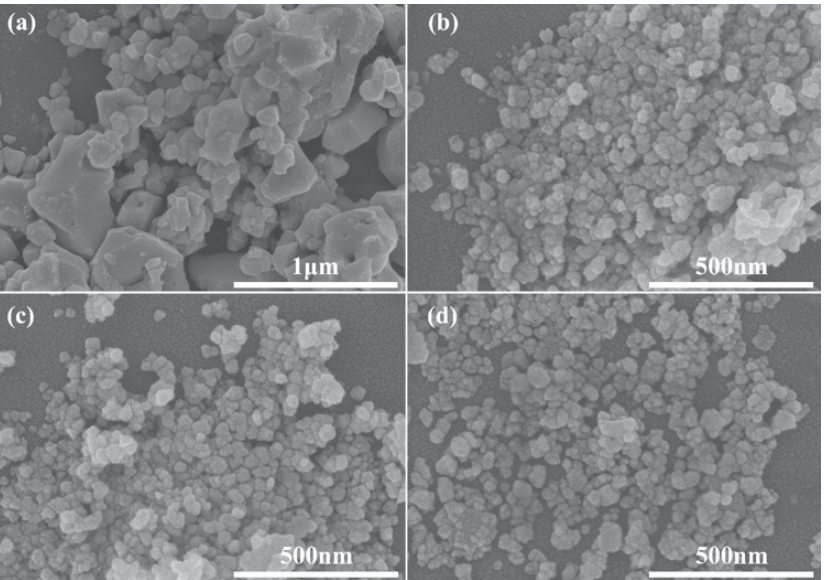
Figure 2. FESEM micrograph of cerium oxide doped with lanthanum at different concentrations: ( a )